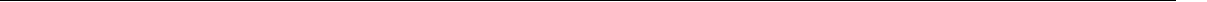
Fig. 3 Sequence alignment and homology models of the tenascin family FBG domains. a Multiple alignment analysis of the FBG domain of tenascin family members highlighting the secondary structure of the predicted protein models. Blue line indicates the A-subdomain, red line indicates the B-subdomain, and yellow line indicates the P-subdomain. The alignment was colored according to the Clustal color scheme. Light blue: hydrophobic, red: positive charged, green: polar, pink: conserved column of cysteine, violet: negative charged, orange: glycine, yellow: proline, cyan: aromatics. The overlapping sequence of peptides 5 and 6, the sequence of peptide 7, and the C terminus are indicated with purple, black, and gray boxes, respectively. b Homology models of the FBG domain of tenascin-C, -R, -W, and -X highlighting the amino acid composition in loop 5, loop 7, and loop 10. The sequence of loop 5 is depicted in pale orange, within which positively charged residues are colored red, any positive residues in the C-terminal loop 10 are also colored red. The sequence of loop 7 is colored pale green within which the triad of polar and hydrophobic residues conserved in FBG-C, -R, and -W but absent in FBG-X, are colored purple, dark green, and